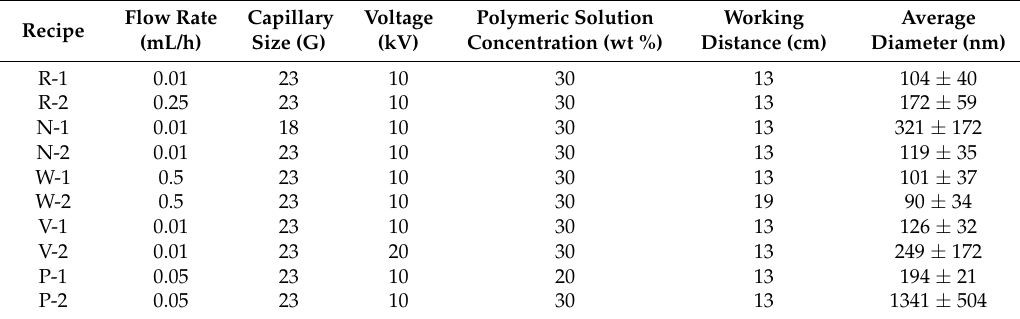
Table 1. Average diameters of the prepared imiquimod-poly( ε -caprolactone) nanofibrous meshes and the electrospinning parameters employed